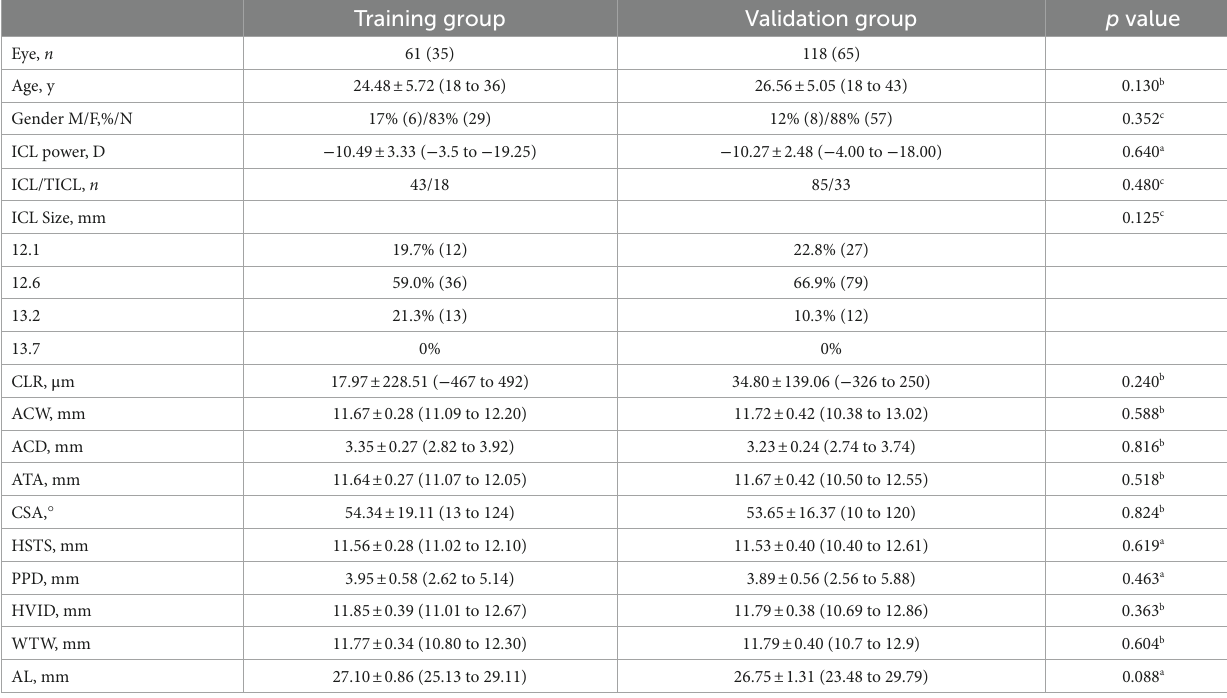
TABLE 1 Population demographics and preoperative ocular dimensions. Training